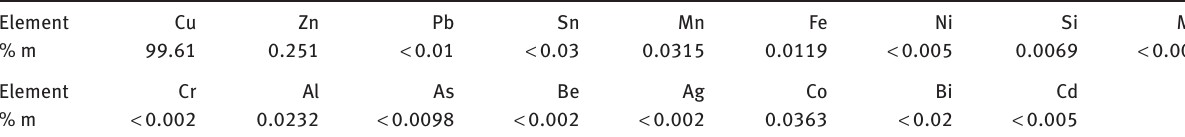
Table 1: Component of elements in Cu.